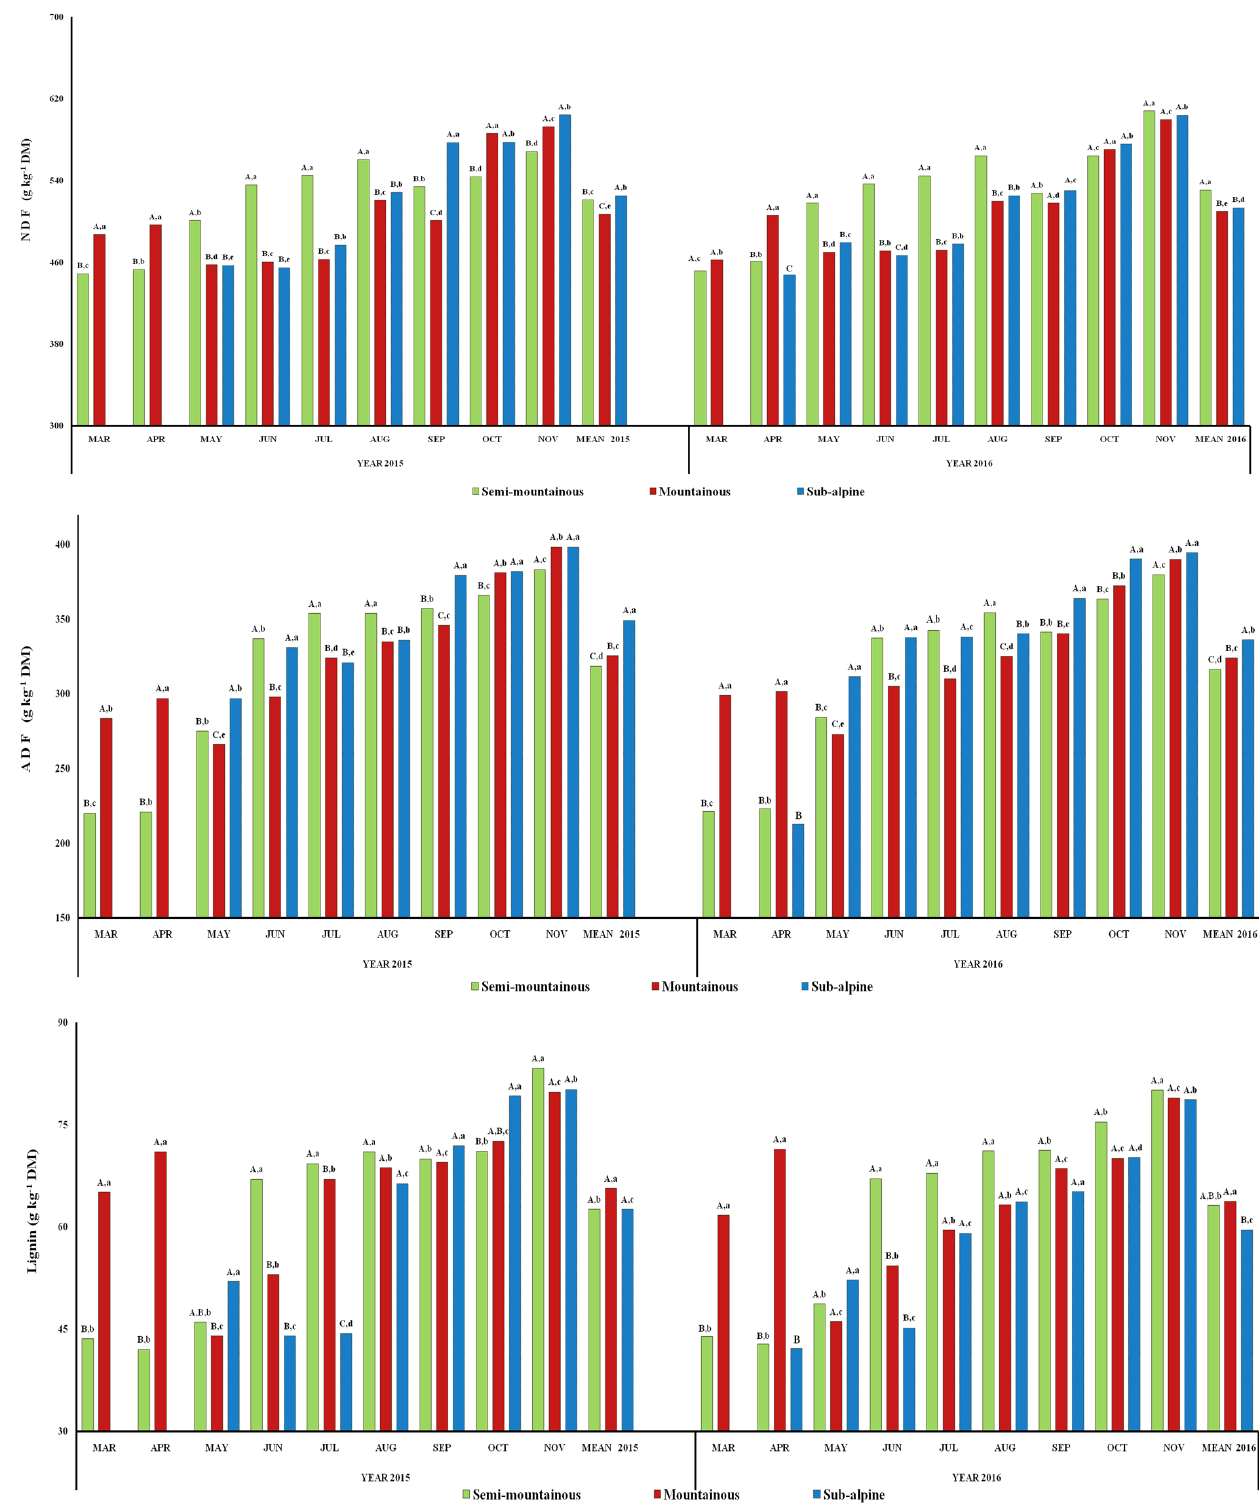
Figure 3. Interannual and monthly variation of herbage cell wall constituents (NDF, ADF, ADL; gkg − 1 DM) of the semi-mountainous, mountainous and sub-alpine grasslands in the Florina Prefecture, northern Greece. Means of the three grasslands between the 2-year exper- imental period followed by different letters (a–d) along the corresponding bar differ at P < 0 . 05. Means of the three grasslands in the same year of the experimental period followed by different capital letters (A–C) along the corresponding bar differ at P < 0 . 05.